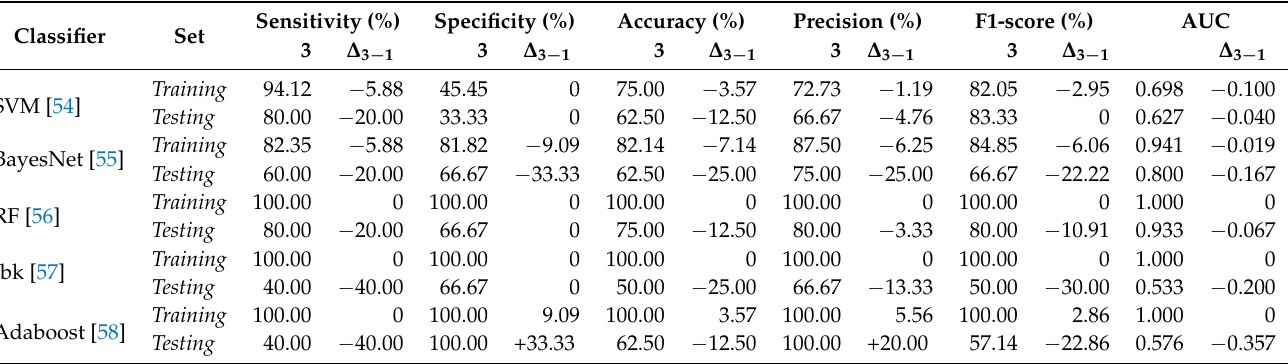
Table 6. Results obtained considering poisoned ECG signals in the training set and clean signals in the testing set (scenario 3)